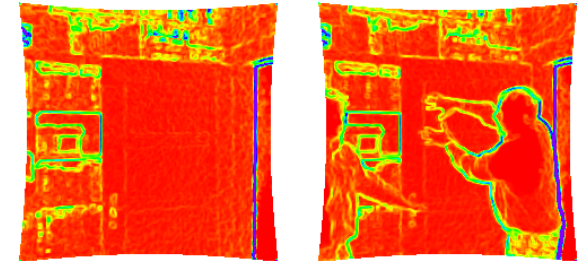
Figure 9: Confidence maps indicating the reliability of the re- spective range information. The reliability is encoded in terms of a color scale reaching from red (reliable) via yellow, green, cyan and blue to violet